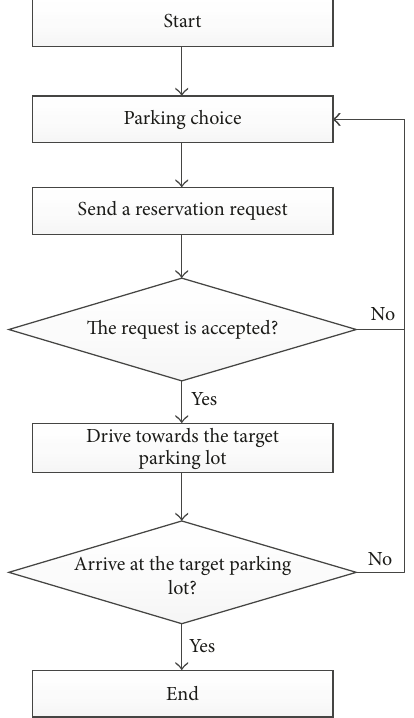
Figure 2: Process of making parking reservation